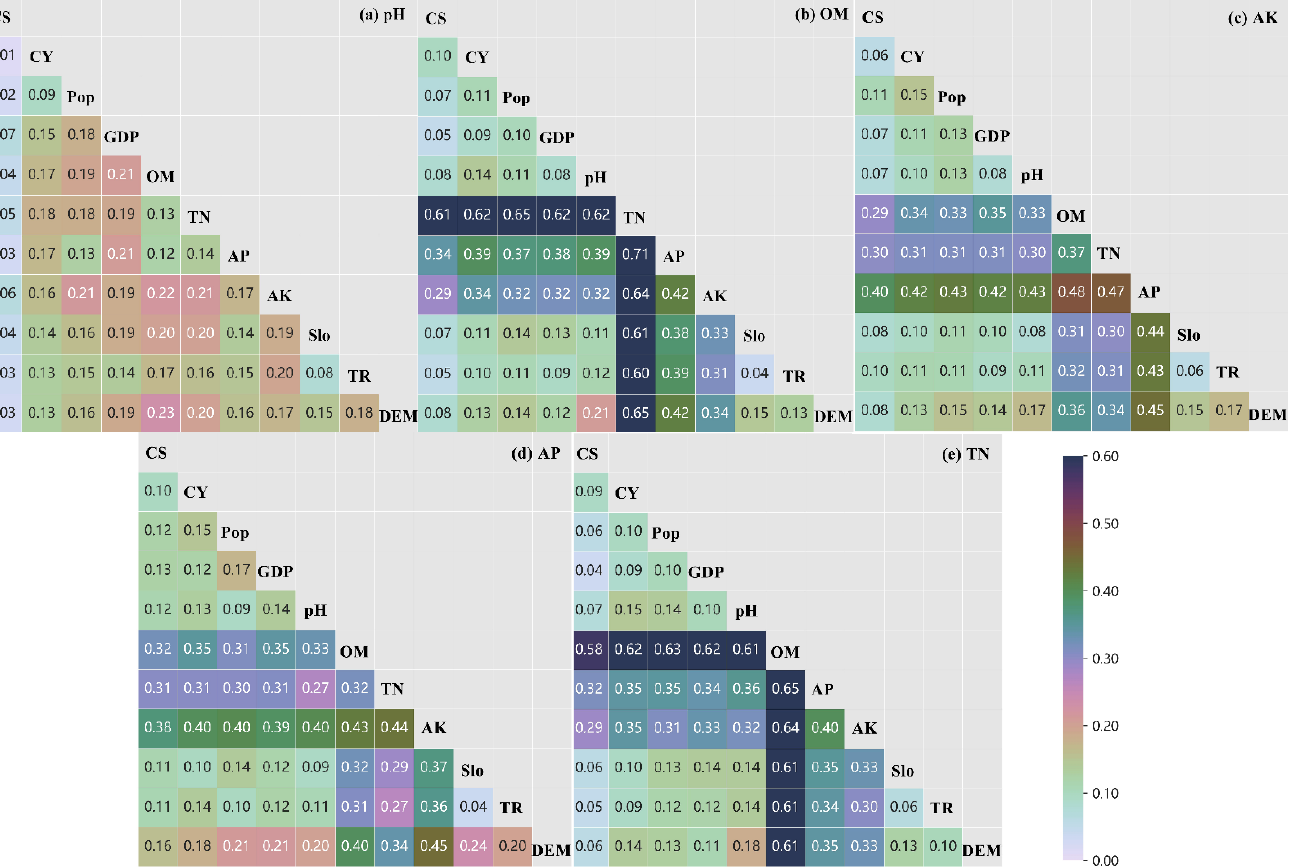
Figure 10. Interaction of Different influence factors on ( a ) pH, ( b ) OM, ( c ) AK, ( d ) AP and ( e ) TN.